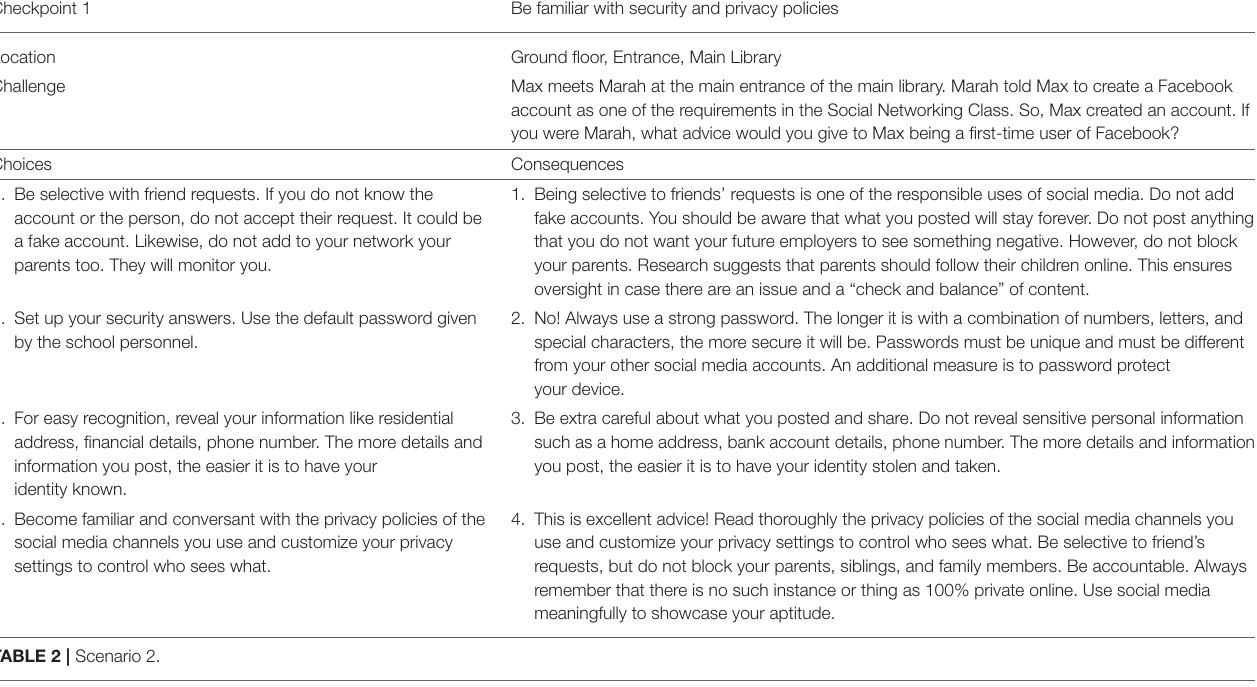
TABLE 2 | Scenario